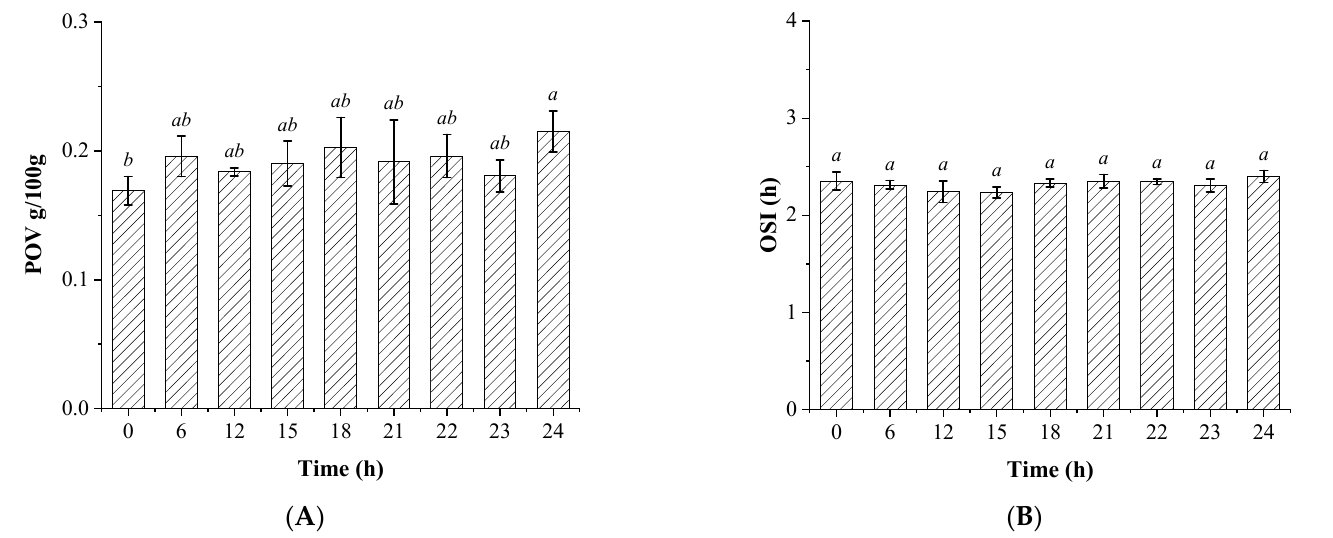
Figure 2. The peroxide value (POV) ( A ) and oxidative stability index (OSI) ( B ) of the soybean oils pretreated by visible light exposure prior to activated clay bleaching. The bars with different lowercase letters in the different groups indicate significant difference under p < 0.05.